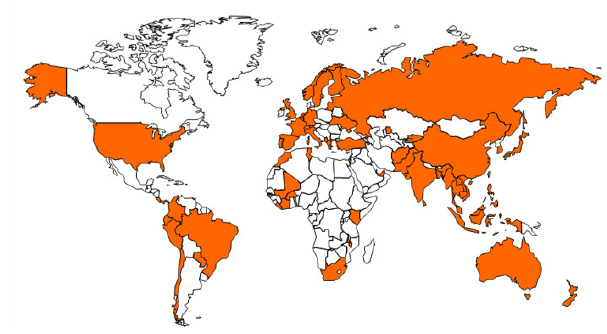
Figure 7. Countries with current FPV